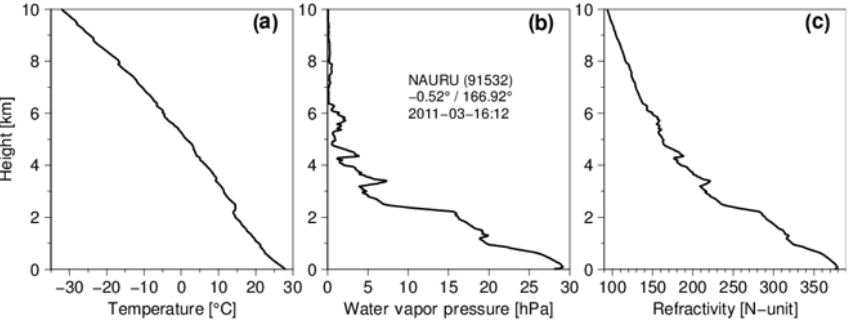
Figure 3. High-resolution radiosonde sounding at a tropical site in Nauru (0.52 ◦ S, 166.93 ◦ E) at 12:00UT on 3 March 2011: (a) temperature ( ◦ C), (b) water vapor pressure (hPa), and (c) refractivity (N unit).